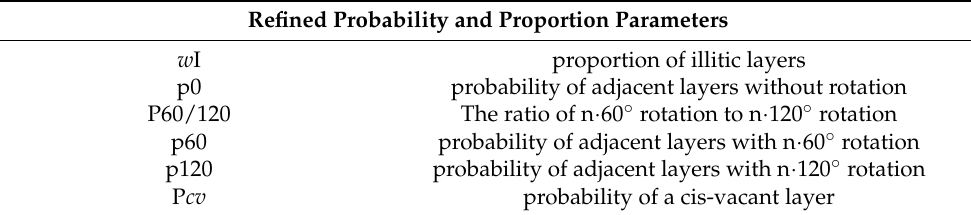
Table 2. The main refined probability and proportion